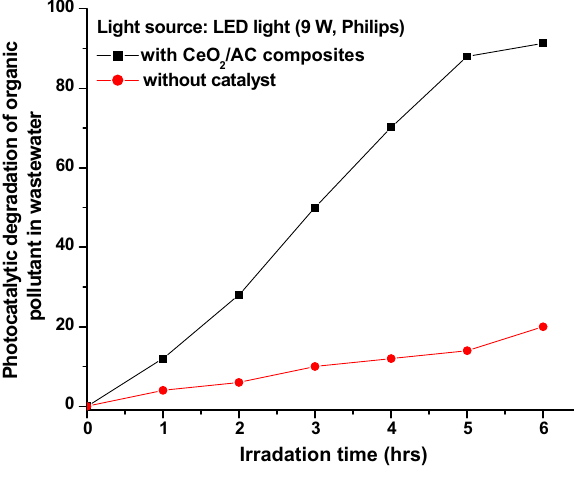
Fig. 9 Effect of catalyst load on photocatalytic degradation efficiency of CeO 2 /AC composite